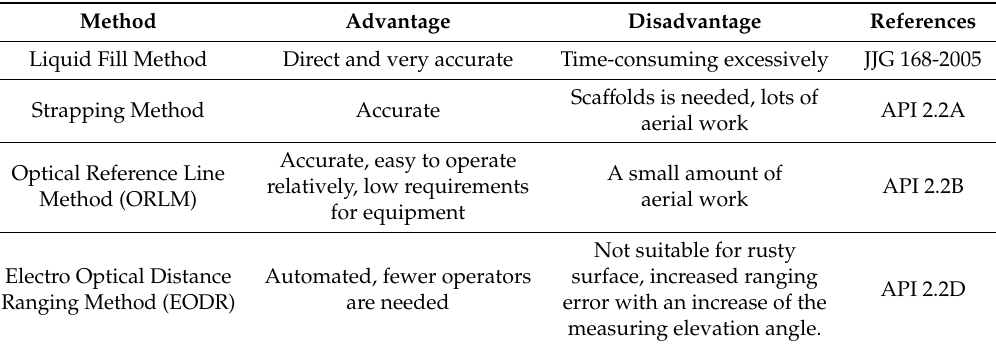
Table 1. Advantages and disadvantages of di ff erent methods.